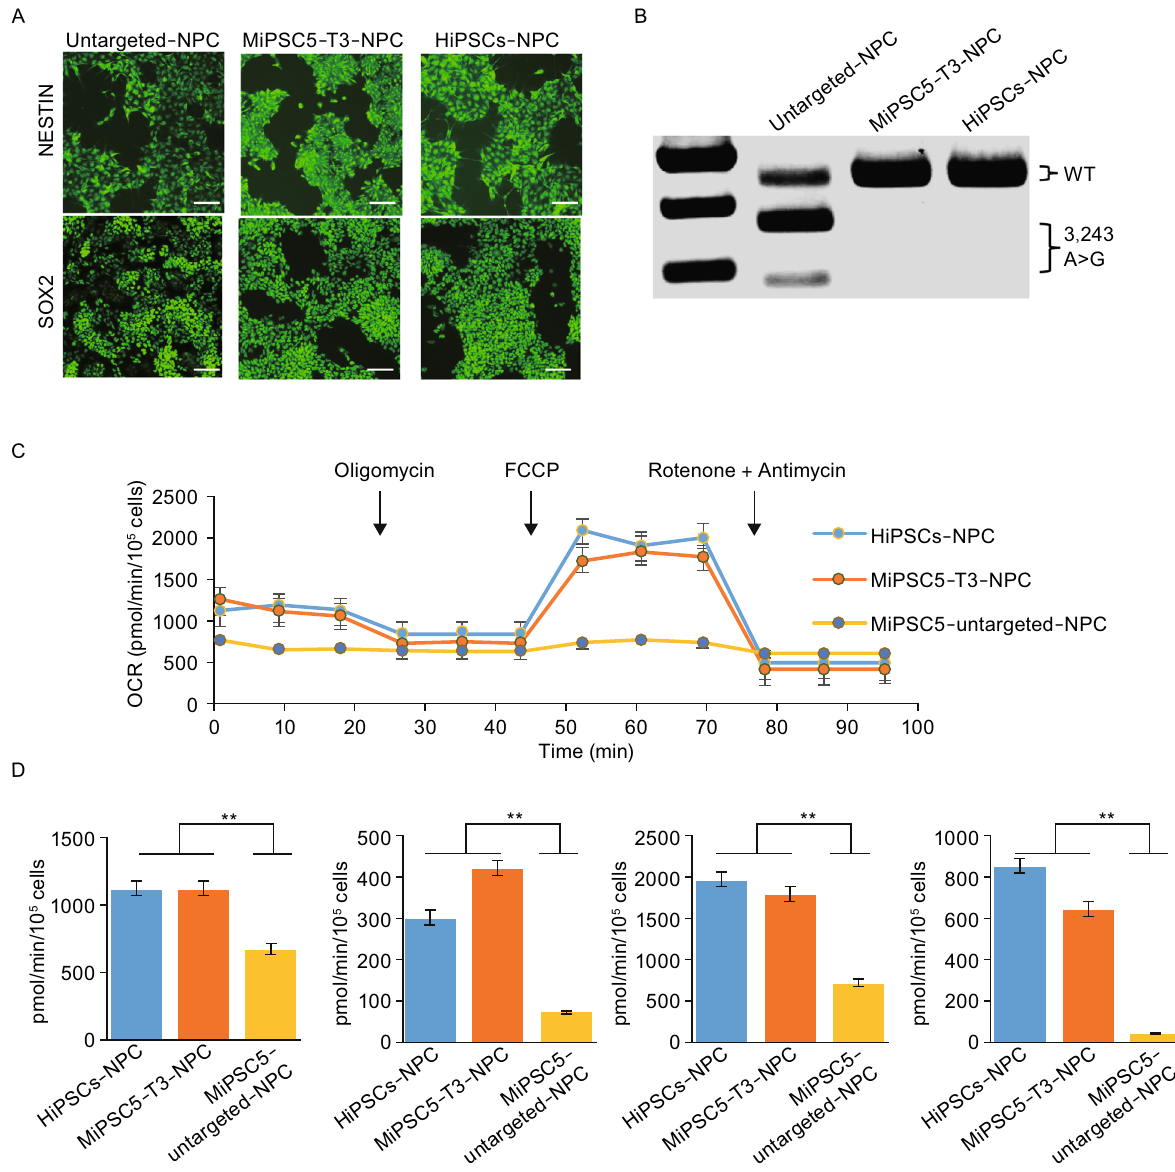
Figure 5. Mitochondrial respiratory function of neural progenitor cells differentiated from MELAS-iPSCs. (A) Immuno fl uo- rescence analysis of neural progenitor markers in MELAS-iPSC-derived NPCs. Scale bar, 100 mm. (B) RFLP analysis and quanti fi cation of m.3243A>G heteroplasmy in MELAS-iPSC-derived NPCs. (C) OCR of the NPCs differentiated from wild-type hiPSCs, MELAS-iPSCs and targeted subclones. (D) Quantitative analysis of basal oxygen consumption, ATP production, maximal respiration and proton leak of NPCs ( n = 3, error bars represent ±SEM; ** P <